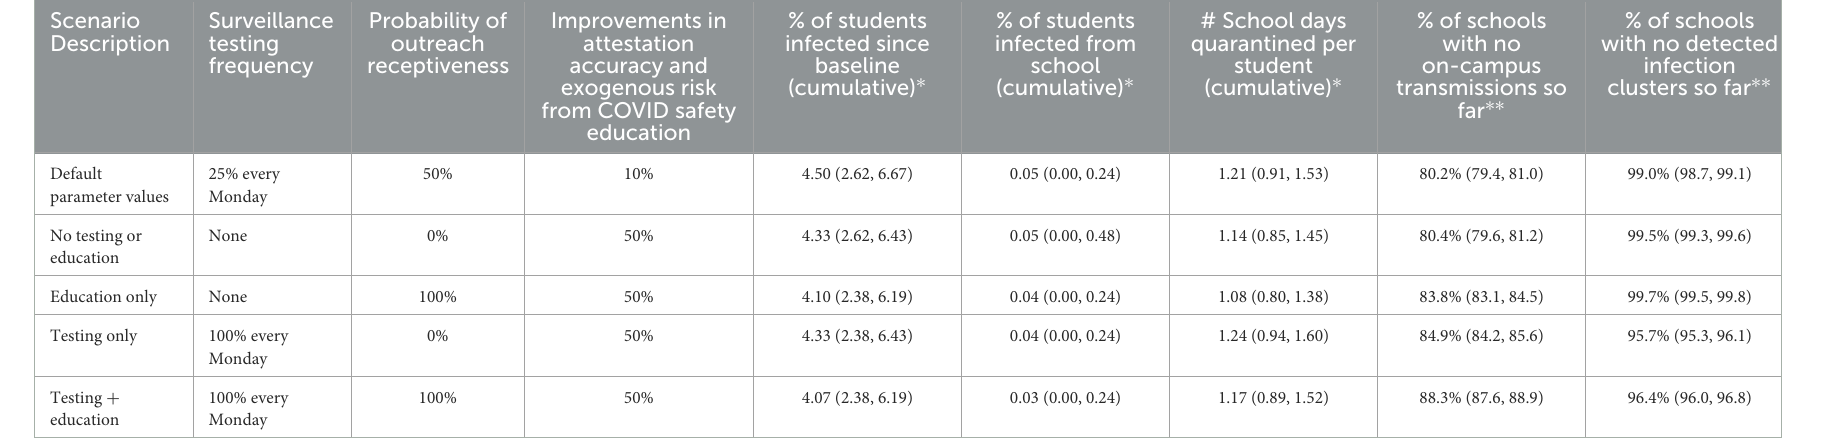
TABLE 5 Scenarios assessing the effects and interactions of surveillance testing and educational outreach to